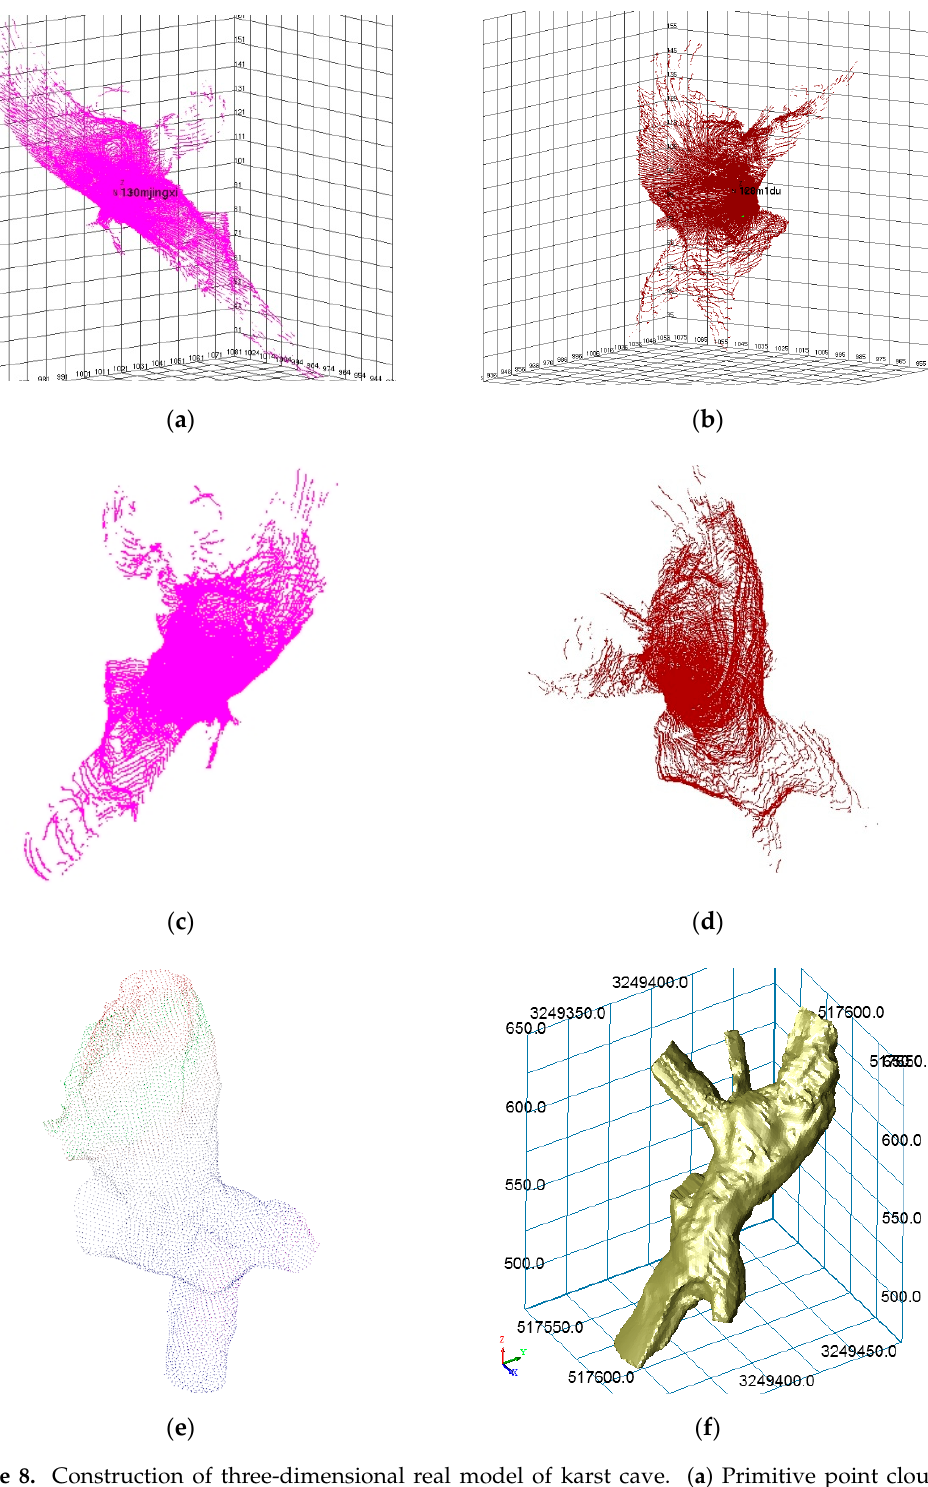
Figure 8. Construction of three-dimensional real model of karst cave. ( a ) Primitive point cloud of borehole #1; ( b ) Primitive point cloud of borehole #2; ( c ) Point cloud after splicing borehole #1; ( d ) Point cloud after splicing borehole #2; ( e ) Point cloud model after splicing boreholes #1 and #2; ( f ) Three-dimensional solid model of karst cave.